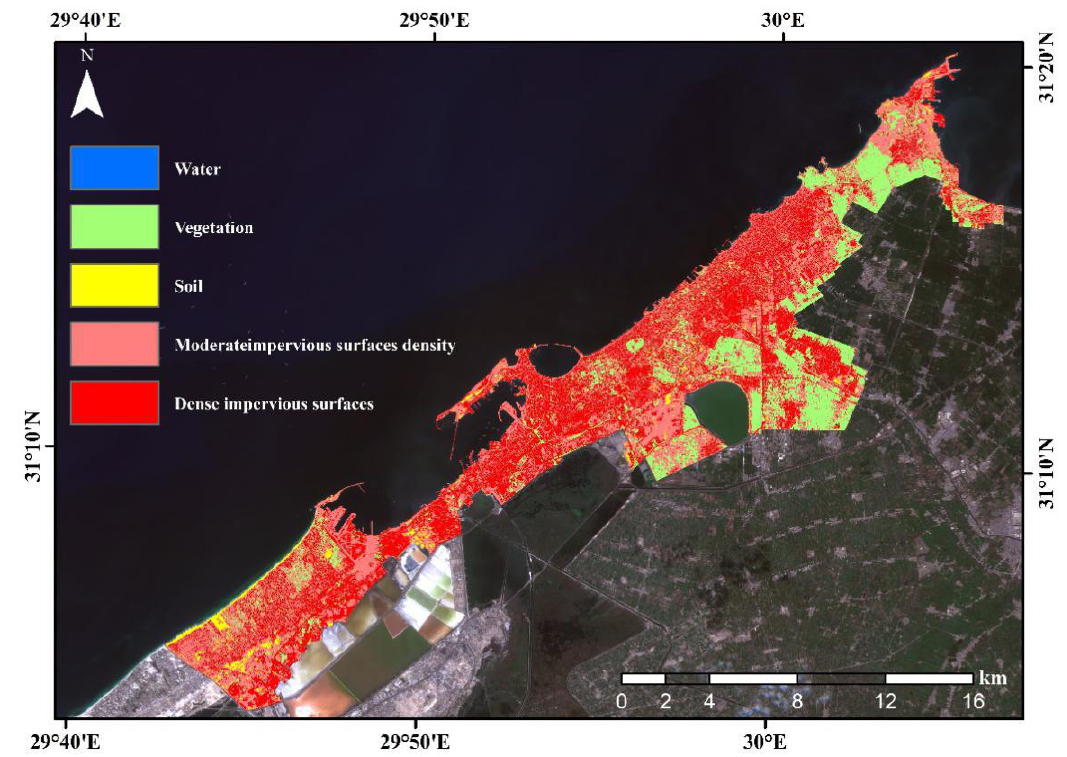
Figure 4. Land cover classification of S-2 image of 24 October 2018 presented on its true color image.